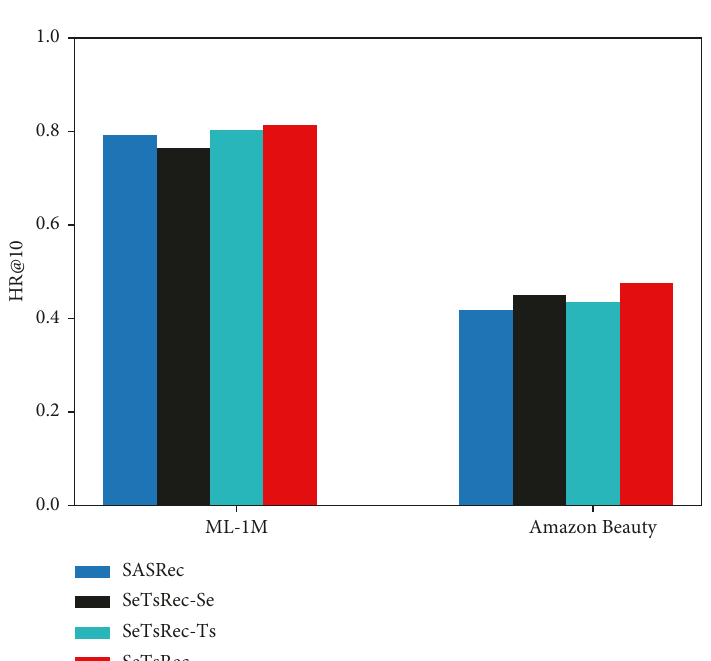
Figure 10: Results of ablation experiment on HR@10.